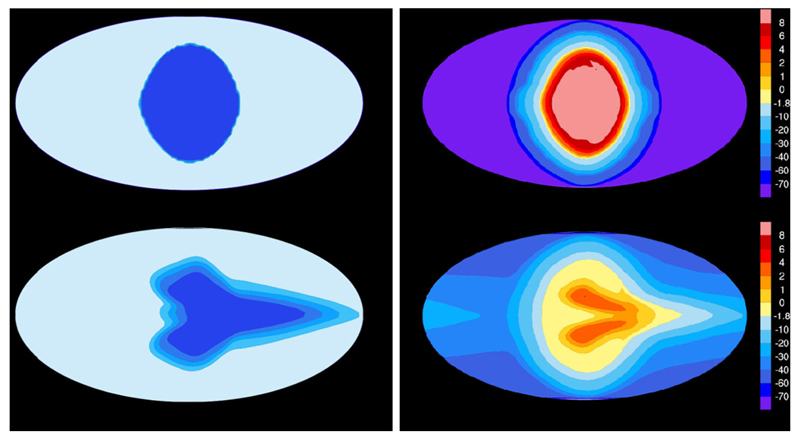
Spatial patterns of open-ocean areas and surface temperatures. Left panels: sea-ice fraction. Blue colors indicate open-ocean areas, and light-gray indicates ice coverage. Right panels: surface temperatures, color bar unit is °C. Top panels: with only atmospheric heat transport, and bottom panels: heat transports by both atmosphere and ocean. The substellar point is at the center of each panel. After Hu and Yang Hu and Yang (2014)